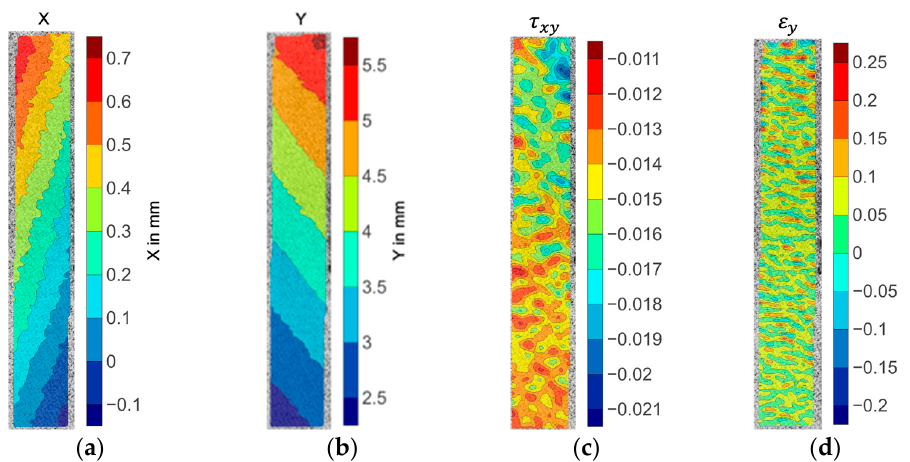
( d ) Figure 8. Representative DIC displacement and strain fields of 15° off-axis tension specimen: ( a ) X direction displacement field; ( b ) Y direction displacement field; ( c ) Shear strain field; ( d ) Tension strain field. The displacement and strain fields of specimens with off-axis angles of 30°, 45° and 60° are alike. Therefore, a representative displacement and strain field of a 30° off-axis tension specimen is illustrated in Figure 9. The displacement fields have a uniform distri- bution along the fibre direction. The highest Y direction displacements emerge at the up-